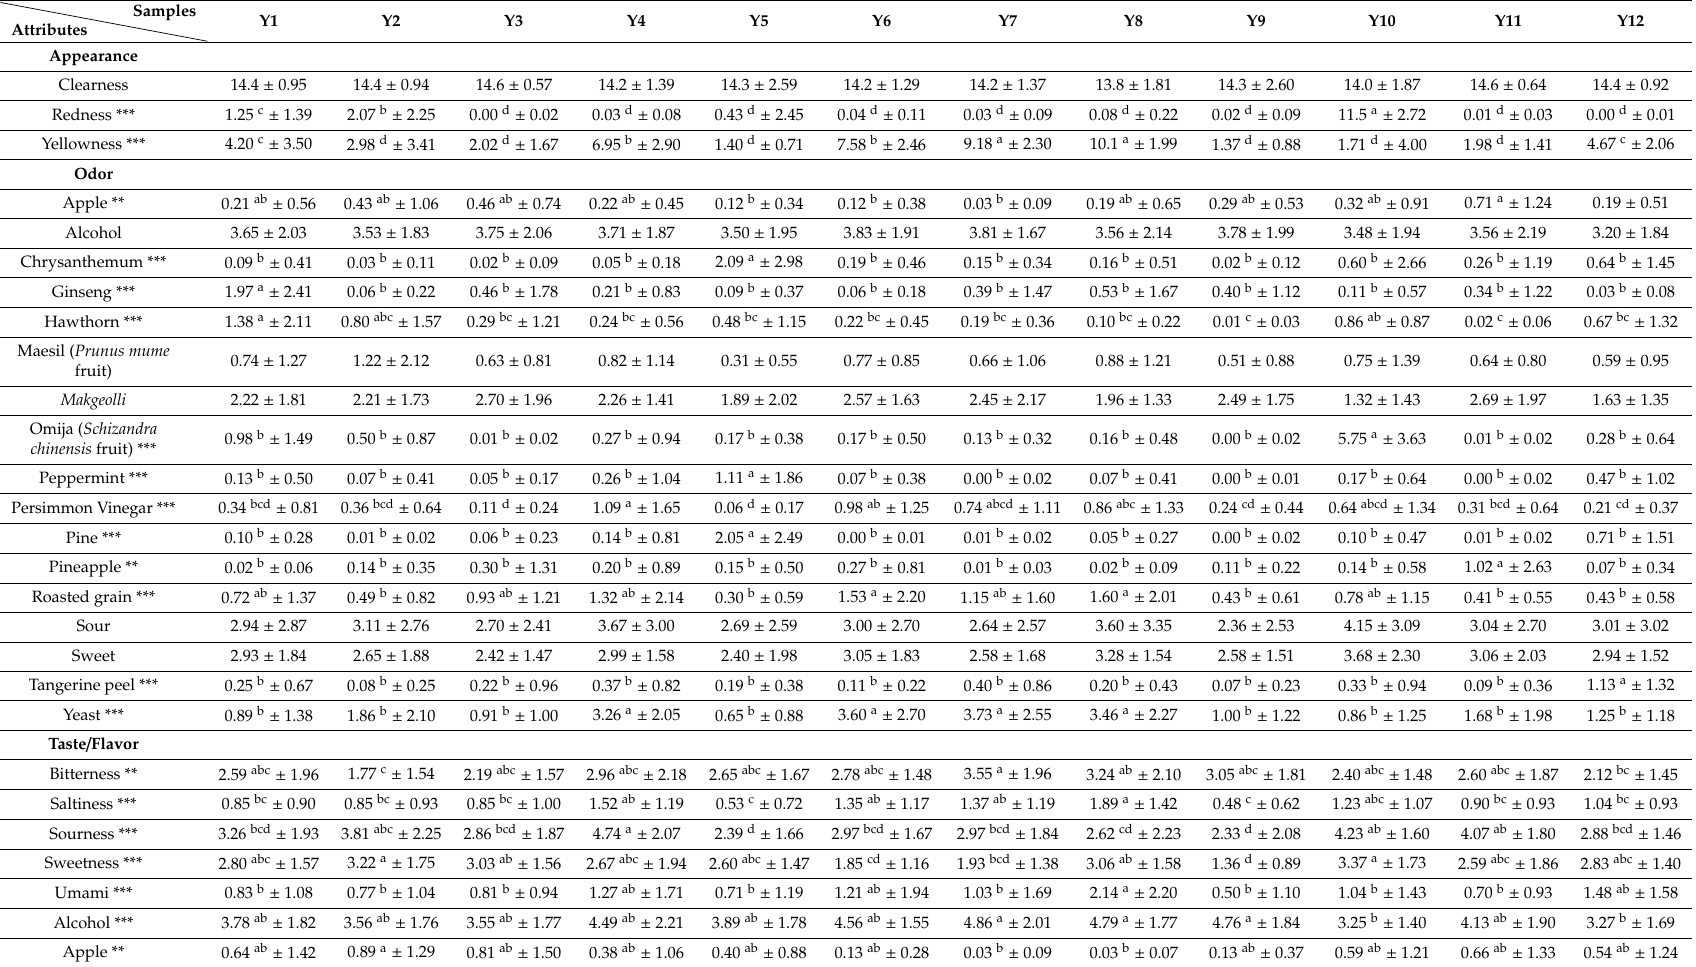
Table 3. Mean intensity scores of the sensory attributes for 12 yakju samples 1–3